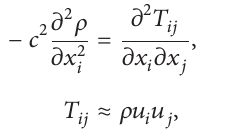
Figure 21: Contours of real part of power of Lighthill’s stress tensor at fundamental frequency, 𝜕 2 T cavity flows with acoustic resonance ( D / L = 2.5). (a) Cavity flow without freestream turbulence (Tu = 0.0%). (b) Cavity flow with freestream turbulence, Tu =